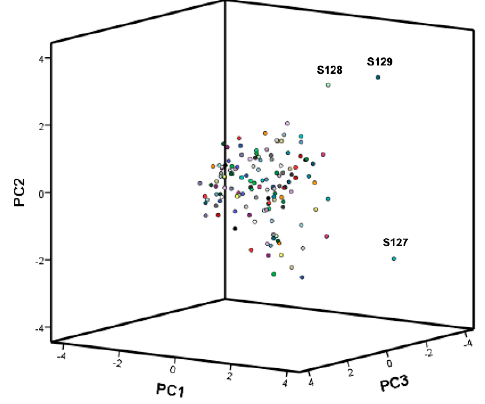
Figure 2. The 3D projection classification map of principal component analysis (PCA) for all the samples.